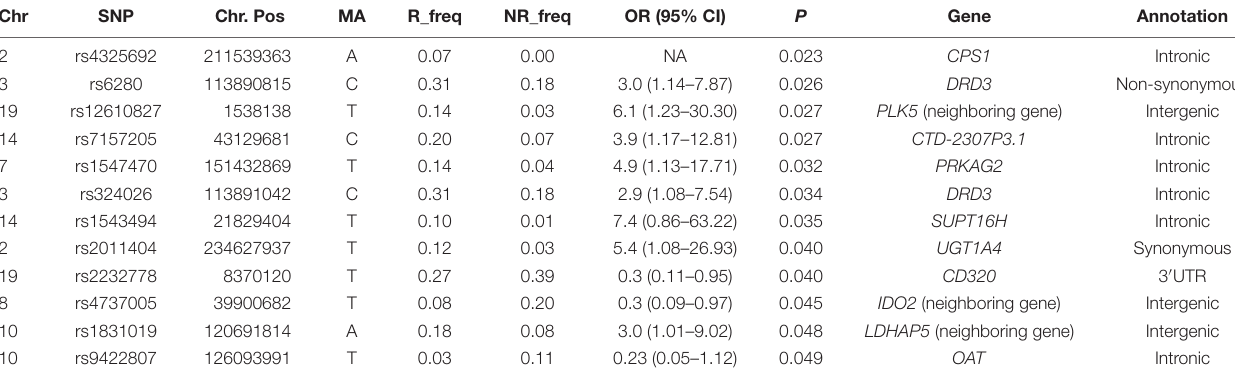
TABLE 2 | 12 SNPs that were found to be significantly associated with responses to olanzapine treatment, by targeted sequencing. Chr